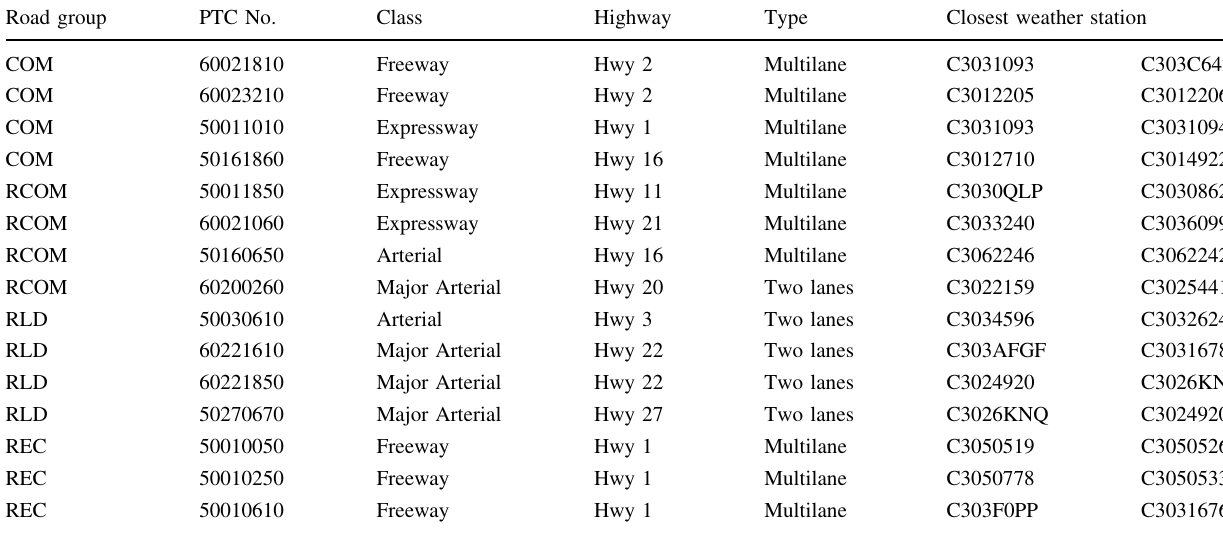
Table 1 Detailed information of PTC sites selected for study Road